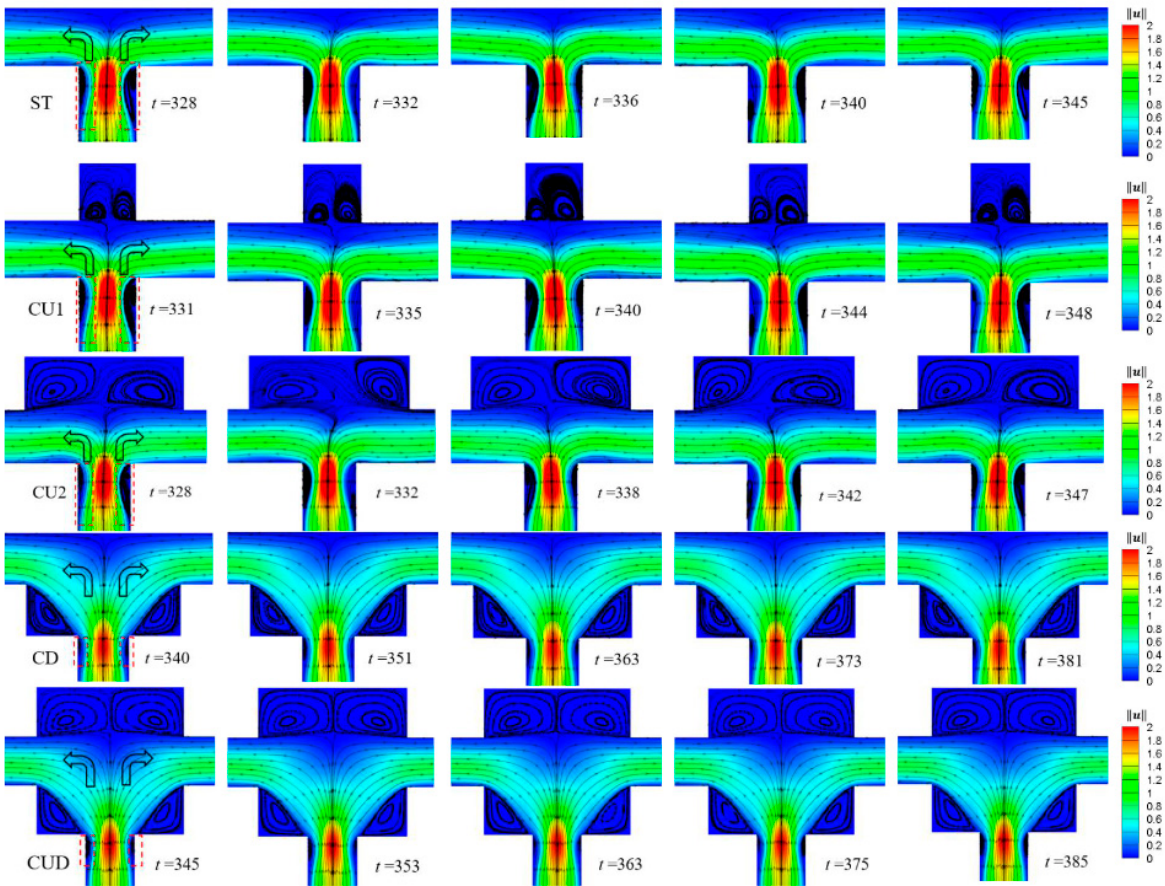
Figure 12. Contour plots of velocity magnitude ‖𝒖‖ superimposed with streamlines for cases of ST, CU1, CU2 CD and CUD from the top to the bottom. The time of the five columns of graphs approximately corresponds to (𝑛 + 0)𝑇, (𝑛 + 1/4)𝑇, (𝑛 + 1/2)𝑇, (𝑛 + 3/4)𝑇 and (𝑛 + 1)𝑇 of the period of the regular wave, where T is the period corresponding to the fundamental frequency of each case. 𝛽 = 0.5 , Wi = 5 . Note that the first and third columns denote the instants when the mass flow rate of left channel is the maximum and minimum in a period, respectively.